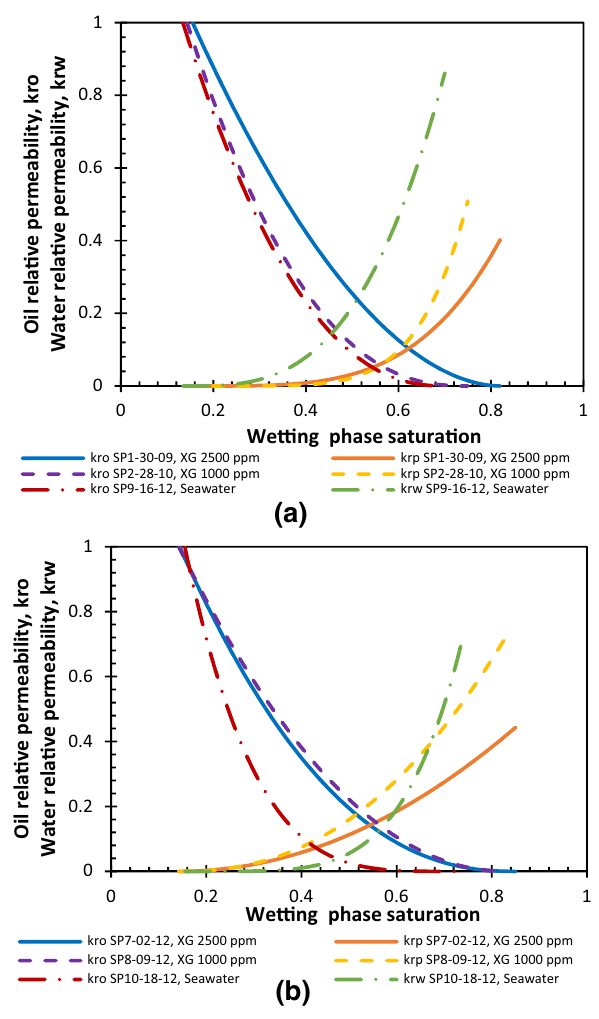
Fig. 11 Relative permeability curves based upon experimental data for different sandpacks a motor oil and b heavy oil